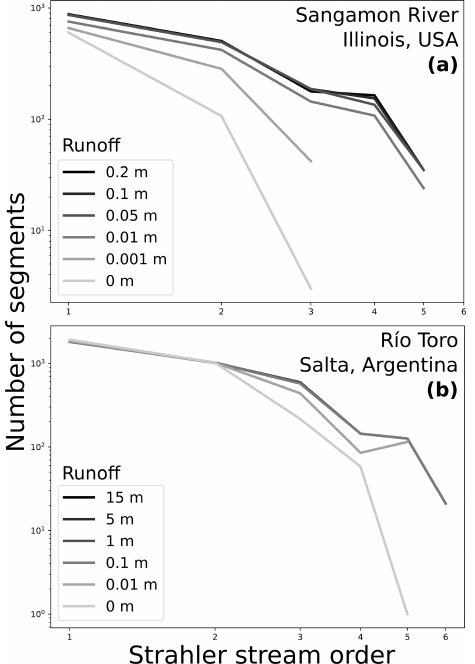
Figure 10. Strahler stream orders. As more water is added to the landscape, more depressions are flooded and drainage integration (and therefore hydrologic connectivity) increases. More stream seg- ments exist overall on the landscape, and they become more con- nected, increasing the fraction of higher-order streams. Lines rep- resenting channel networks with shallower runoff depths overlie those representing deeper runoff for (a) the Sangamon River site and (b) the Río Toro site. We computed the stream orders in GRASS GIS (Neteler et al., 2012) using r.watershed (Metz et al., 2011) to compute stream networks, followed by r.stream.order to calculate the Strahler stream orders (Strahler, 1957).